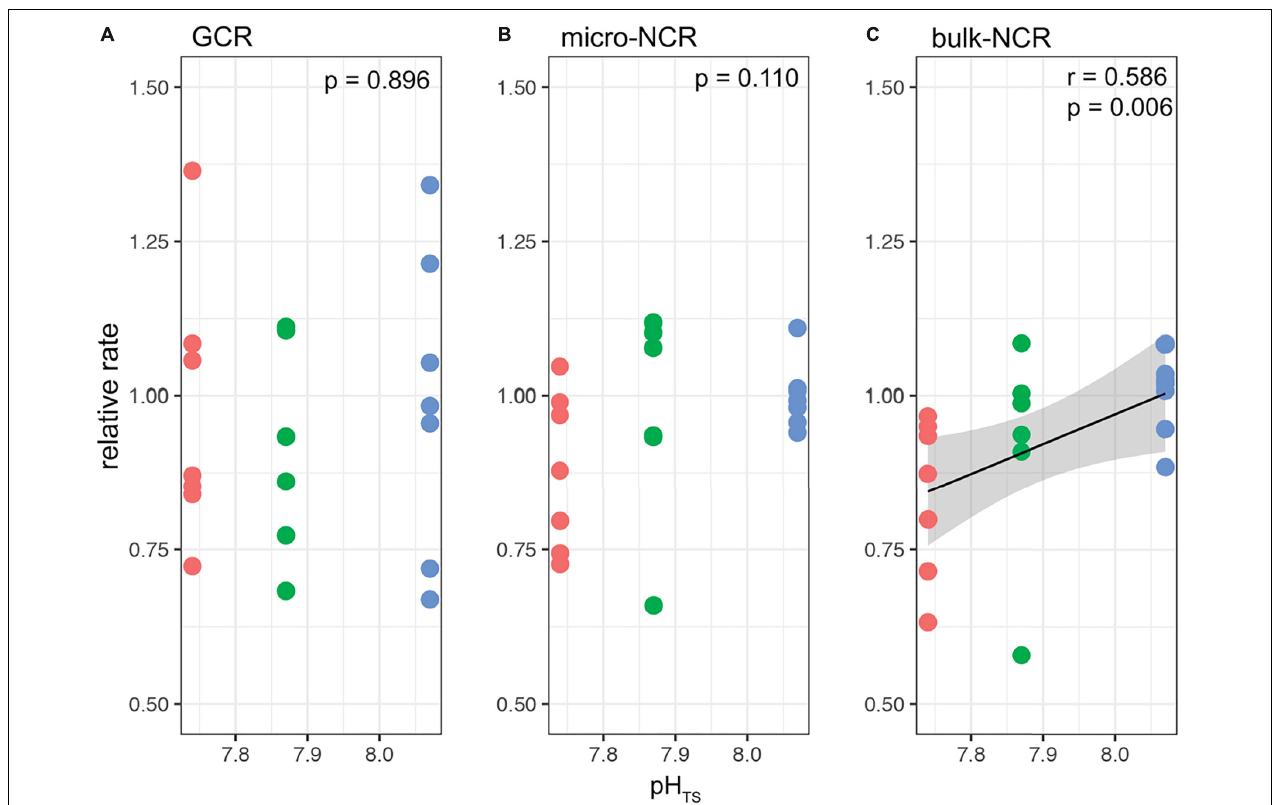
FIGURE 5 | Modeled gross calcification rates (GCR) and comparisons with measured micro and bulk net calcification rates (NCR) in Balanophyllia europaea corals growing along the pH TS gradient at Panarea Island. (A) GCRs were calculated following the IpHRAC model (McCulloch et al., 2012a) (internal pH regulation and abiotic calcification): Gross calcification = k × ( (cid:127) cf − 1) n and presented as relative rates (setting average control growth as 1). (B) micro-NCR and (C) bulk-NCR were derived from bulk density, micro-density and linear extension rates taken from Fantazzini et al. (2015). Circles represent values for each individual coral. Color denotes the different locations: Site 1 = blue, Site 2 = green, Site 3 = red. Black dashed line indicates linear regression and the gray area the 95%-CI band of the significant regression ( p < 0.01; N = 7 for Sites 1 and 3, and N = 6 for Site